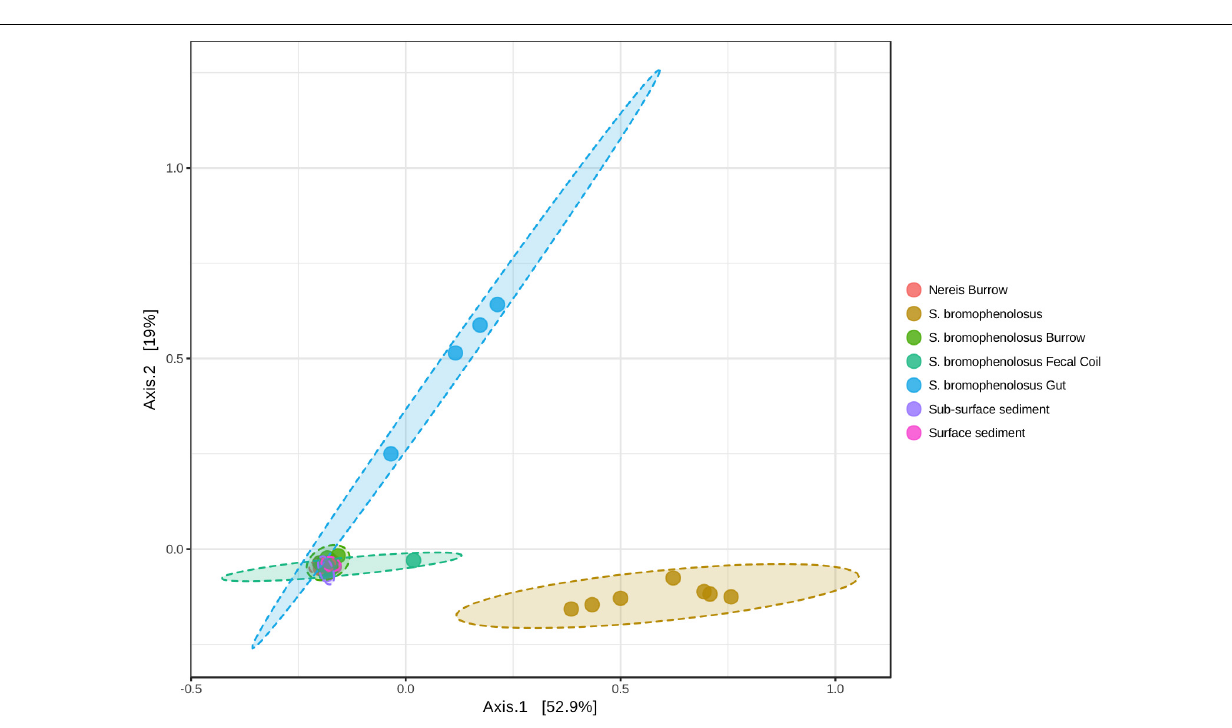
FIGURE 3 | Principal coordinates analysis of animal and sediment microbial communities. Principal coordinates analysis of sample OTUs based on weighted UniFrac distances. PERMANOVA: r 2 = 0.738, p < 0.001; PERMDISP: F = 2.291, p =